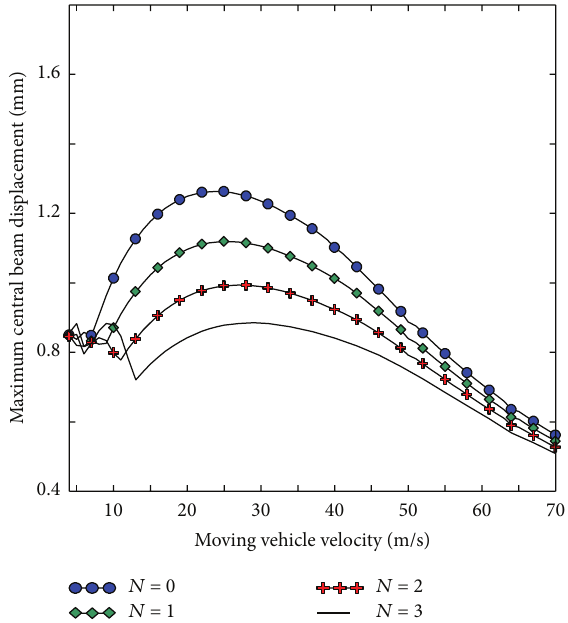
Figure 7: The maximum displacement of the beam at mid-span versus the velocity of the moving vehicle for 𝜁 = 0.075